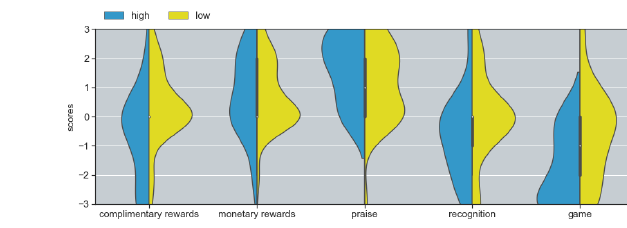
Figure 7. Motivational design techniques regarding incentivisa-